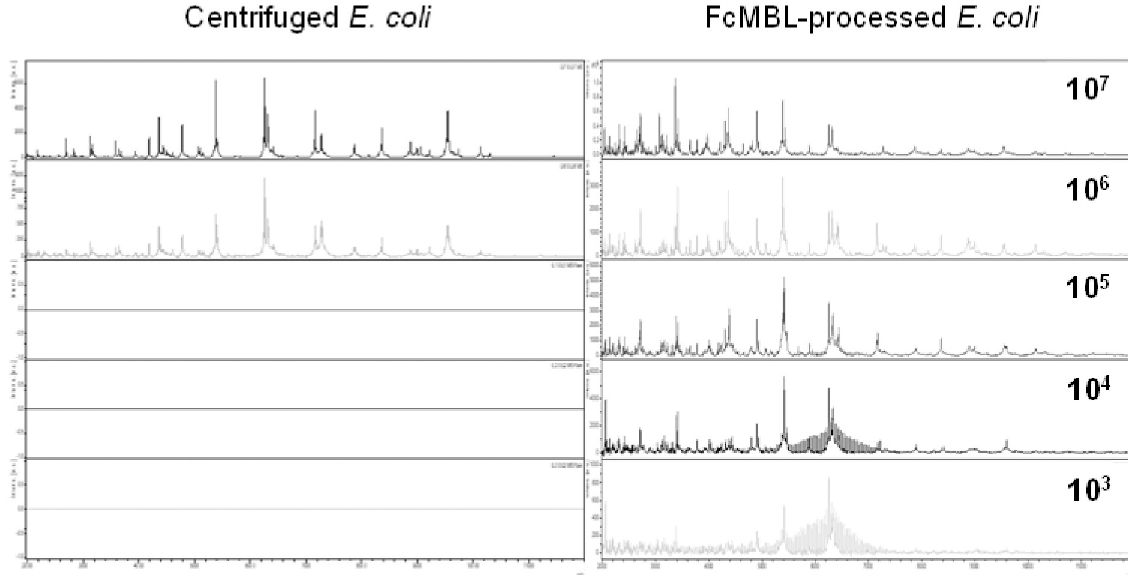
Fig 5. Extreme enrichment of E . coli from spiked blood samples compared to centrifuged samples. E . coli specific peaks are found in all concentrations using the FcMBL method. The limit of detection for the centrifuged samples was found to be at 10 6